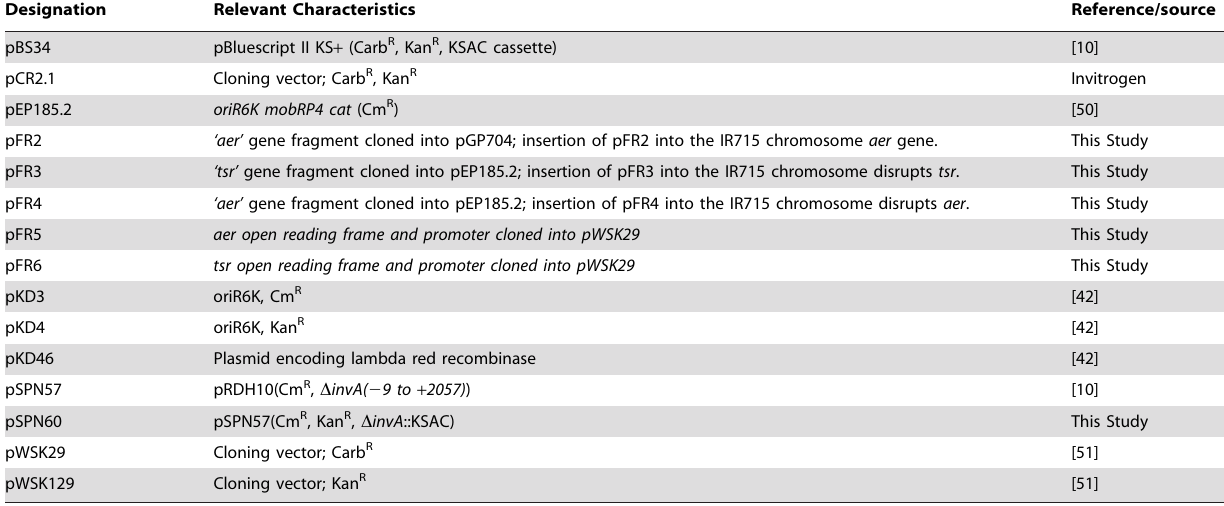
Table 2. Plasmids used in this